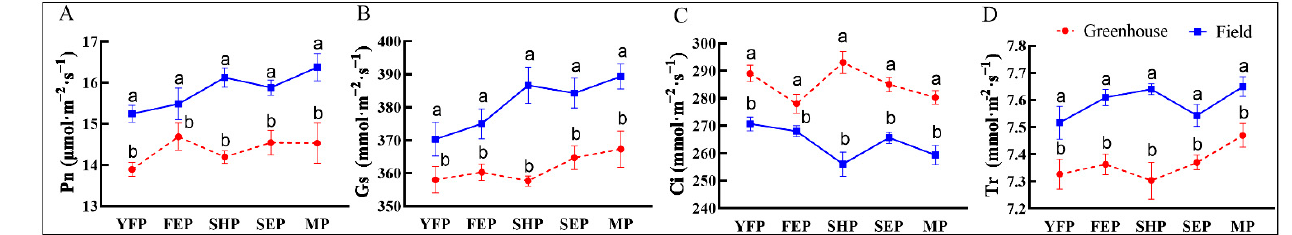
Figure 2. Photosynthetic parameters of peach leaves in the field and greenhouse. ( A – D ) show the photosynthetic rate (Pn), stomatal conductance (Gs), intercellular CO 2 concentration (Ci) and transpiration rate (Tr), respectively. The measurement dates were 3.23–5.18 in the greenhouse environment and 5.2–7.27 in the field environment. The data are presented as the means ± SDs from three biological replicates. Different lowercase letters indicate significant differences ( p < 0.05).